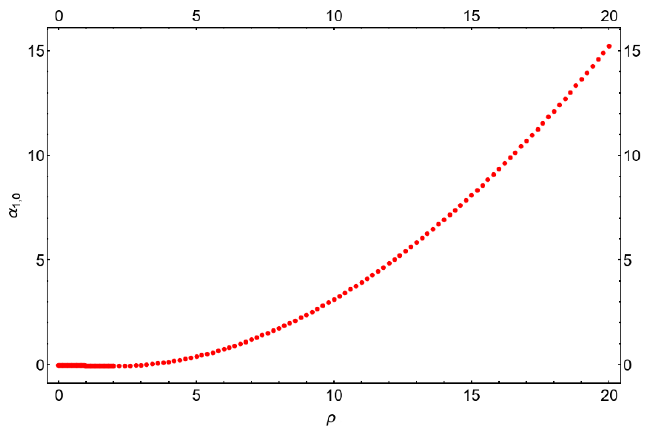
Figure 5 . The di(cid:11)erence (cid:11) 4